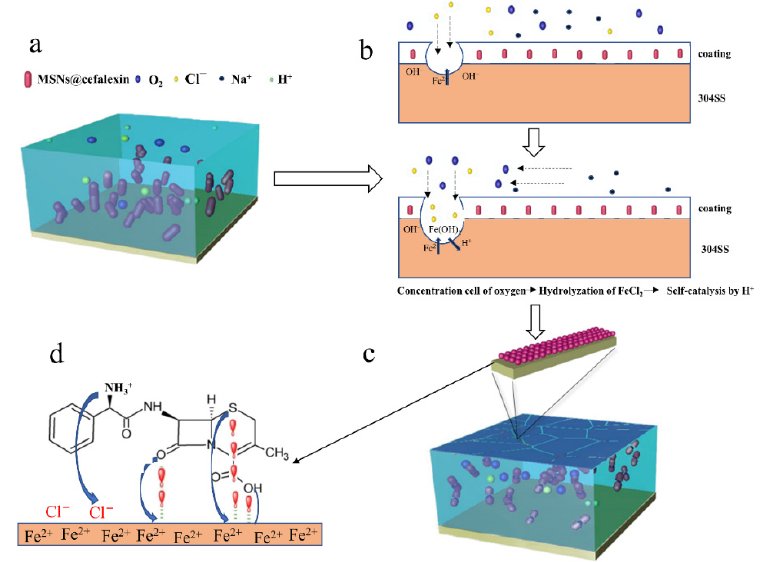
Figure 8. The self-healing mechanism of EP-Cefalexin@MSNs coating: ( a ) Before coating corrosion, ( b ) corrosive medium penetrates into the coating, ( c ) the self-healing process, ( d ) adsorption principle of Cefalexin molecular.